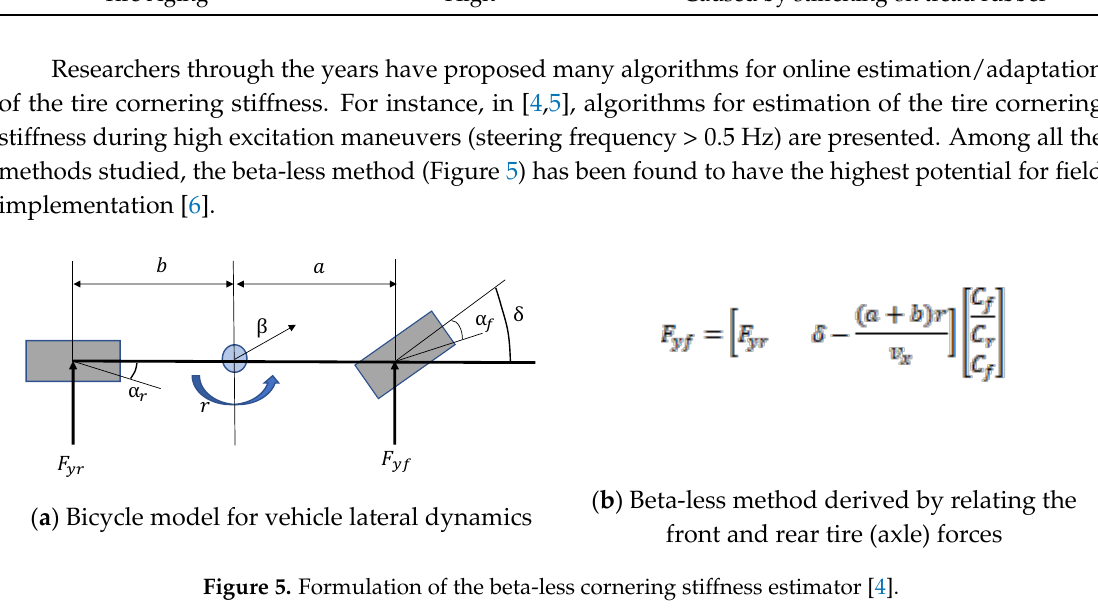
Figure 5. Formulation of the beta-less cornering stiffness estimator [4].